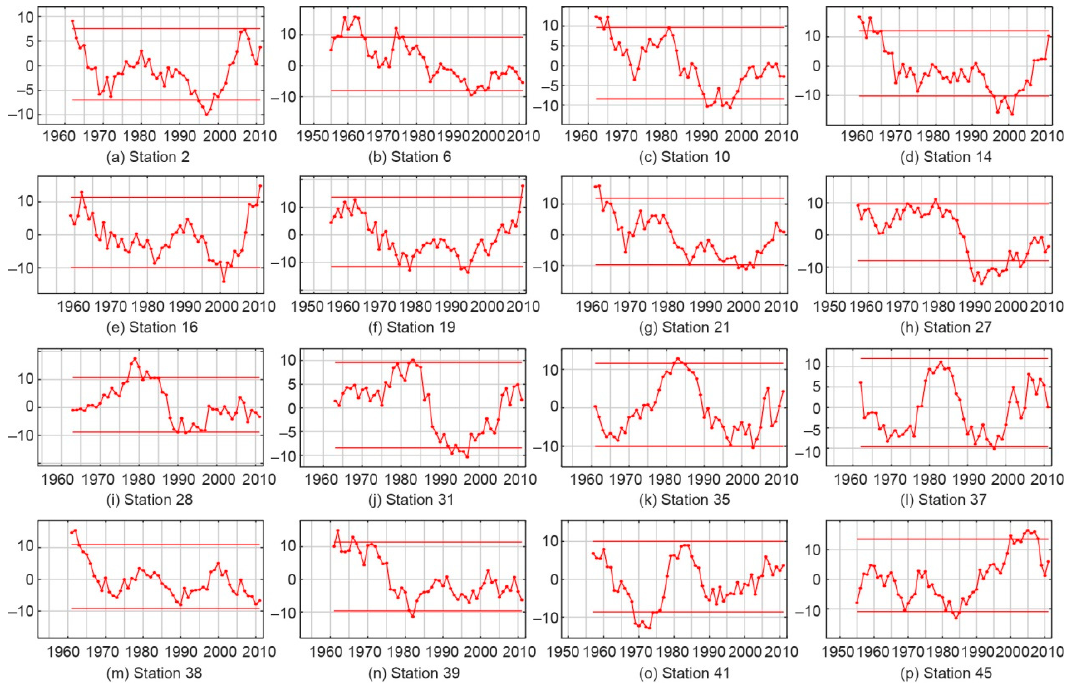
Figure 3. Temporal anomalies in extreme daily rainfall. The y -axis represents the anomaly index in percentage. The straight line denotes the 95% confidence intervals.